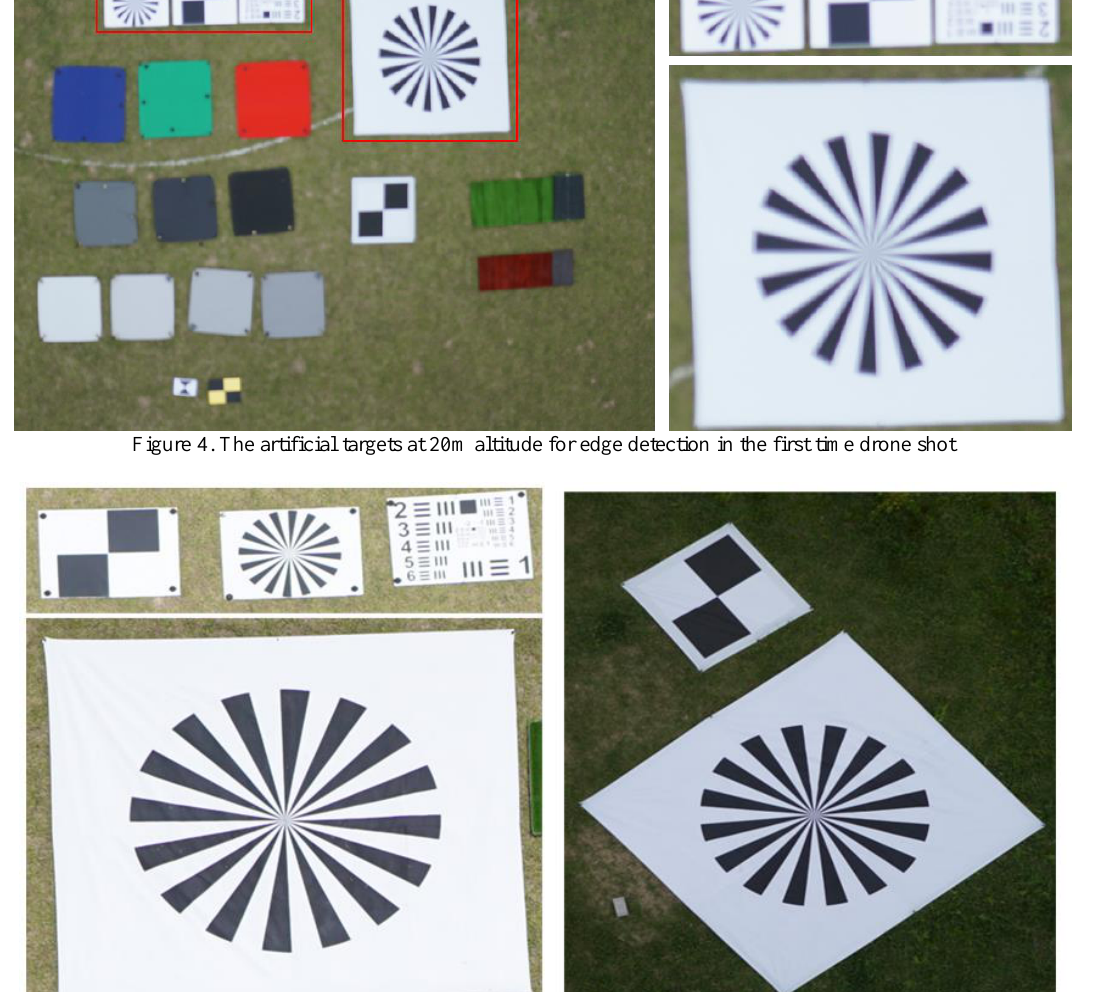
Figure 5. The second and third times drone shot at the same